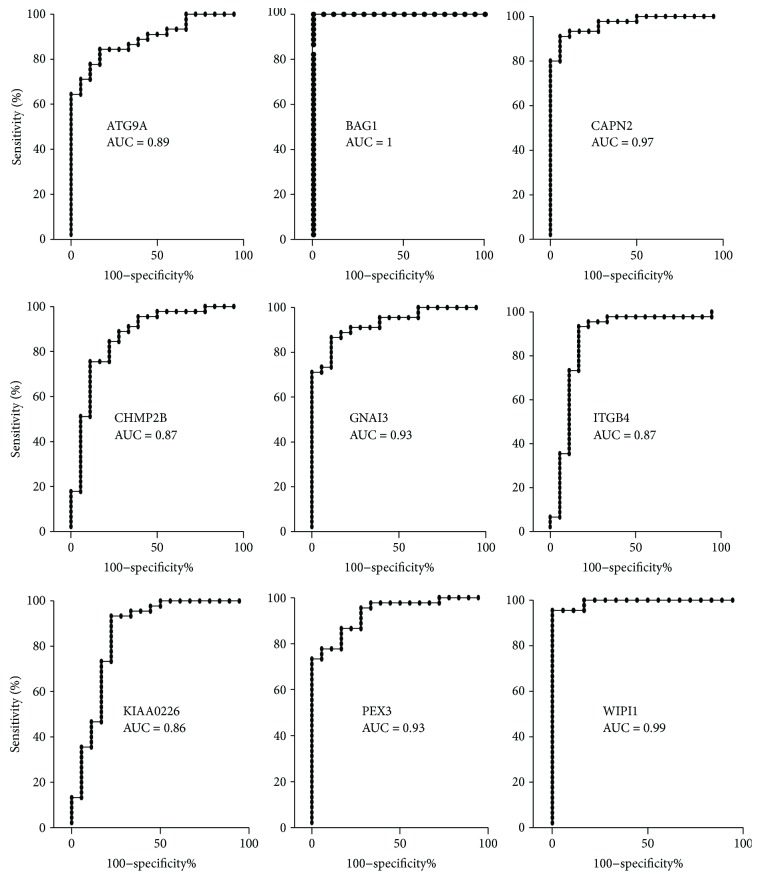
ROC analysis on the expression data of 9 genes never related to melanoma diagnosis or prognosis. The area under the curve (AUC) is plotted as sensitivity% vs 100-specificity%. The calculated AUC is reported in each case. The p value is <0.0001 in all cases.